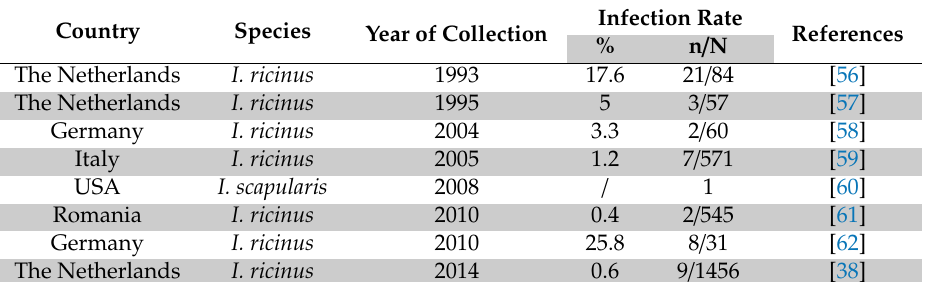
Table 2. Summary of publications reporting infection rates of Borrelia burgdorferi sensu lato in unfed, field-collected Ixodes scapularis and Ixodes ricinus larvae.